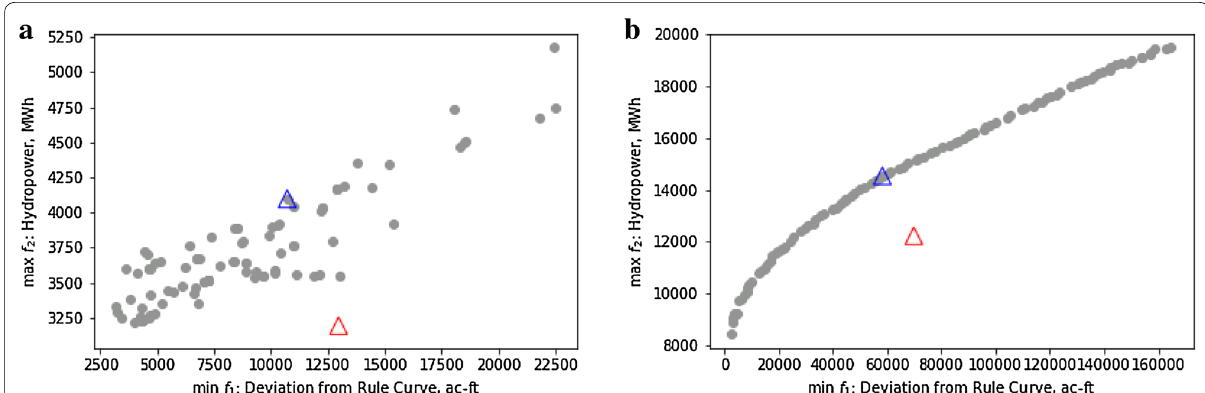
Fig. 10 Sample Pareto frontiers between hydropower generations and storage deviation from rule curve, depicting the optimal release decisions for a 5 Jan 2014 (wet year) and b 4 March 2016 (relatively drier year). Blue triangle represents the selected solution for carrying out sensitivity analysis while red triangle is the location of respective objectives from BAU